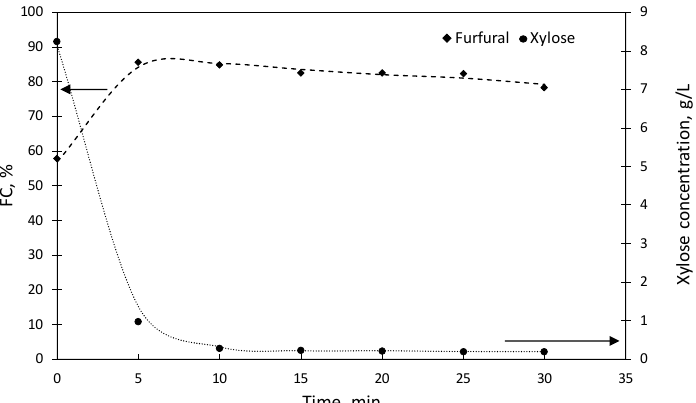
Figure 4. Molar conversions of precursors into furfural, and xylose concentrations in experiments performed at 180 °C using [C3SO 3 Hmim]HSO 4 as a catalyst. Data were obtained at diverse reaction times in media containing 0.049 mol catalyst/L aqueous phase.